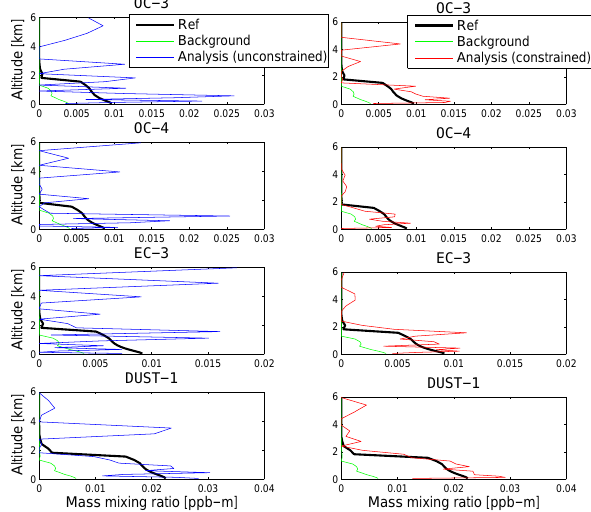
Figure 1. Vertical profiles of selected aerosol components in differ- ent size bins. From top to bottom: organic carbon in the third size bin (OC-3), OC in the fourth size bin (OC-4), elemental carbon in the third size bin (EC-3), and dust in the first size bin (DUST-1). The reference results are shown in black, and the background (first guess) estimate is shown in green. The unconstrained 3DVAR anal- ysis results are presented in the left panels in blue, the constrained 3DVAR analysis results are shown in the right panels in red.